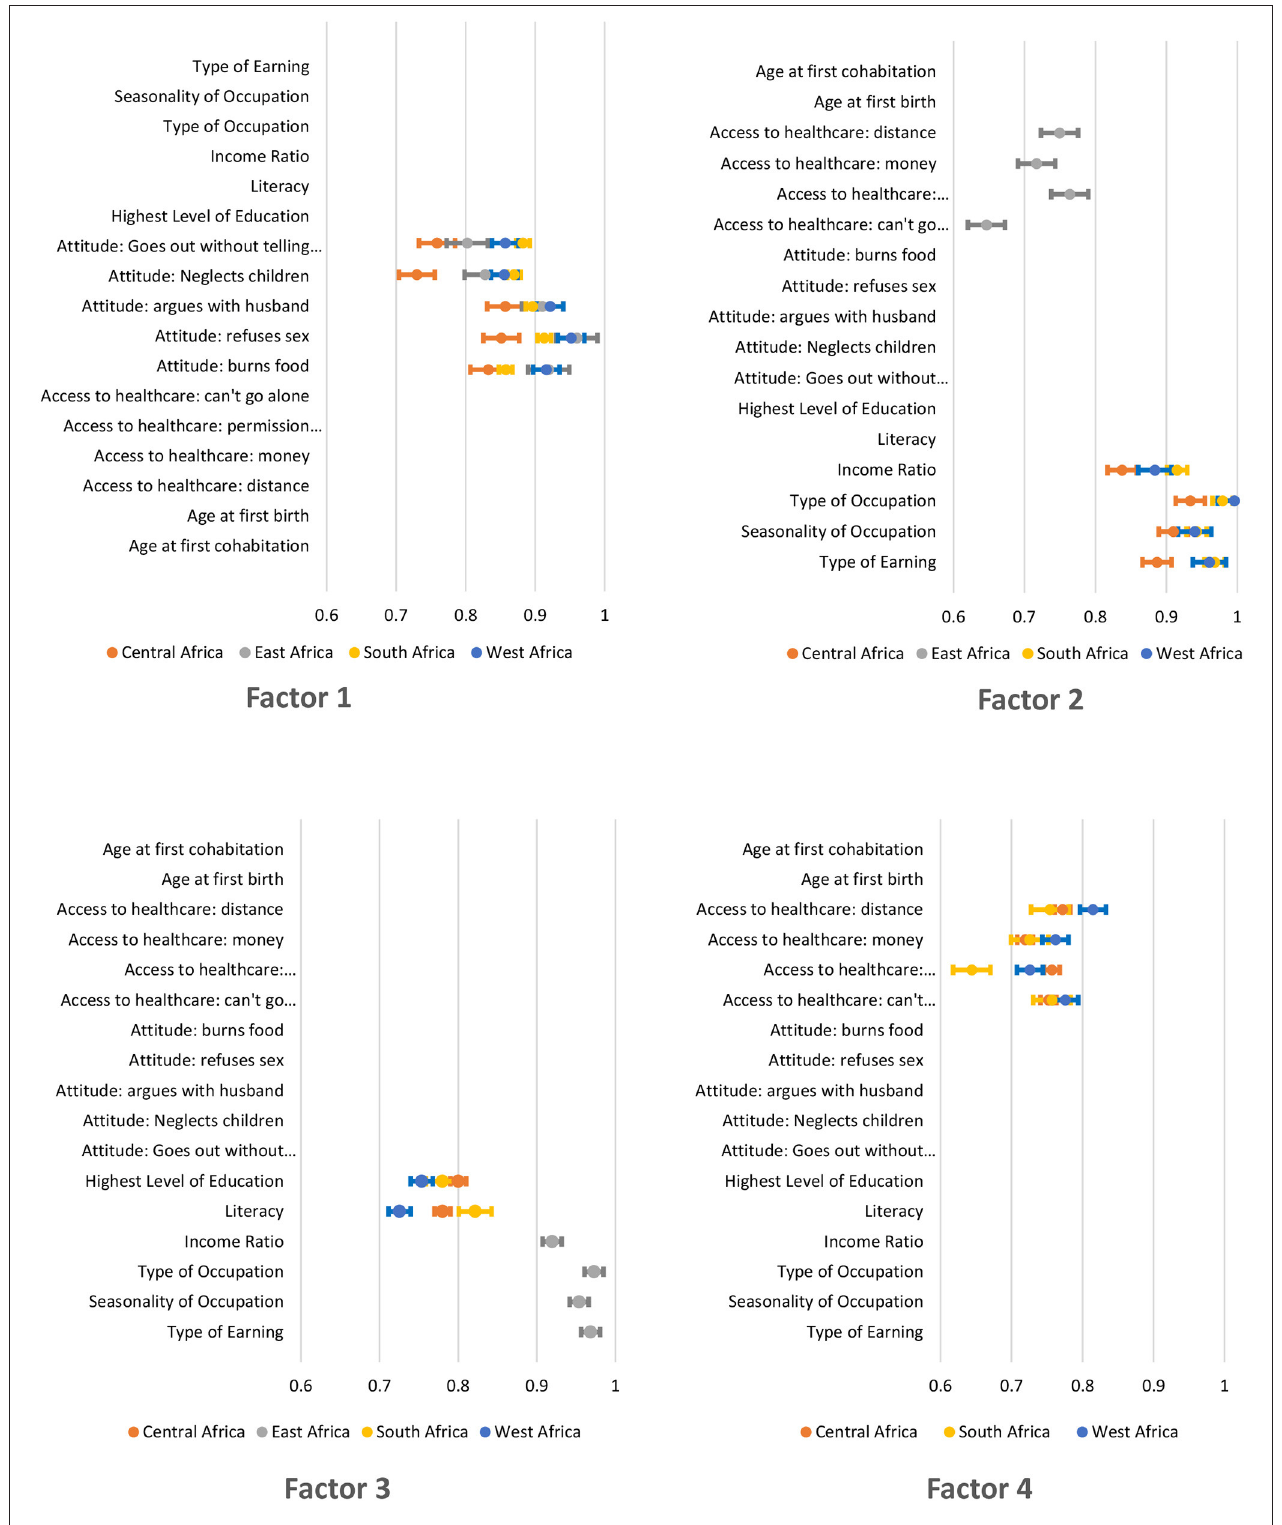
FIGURE 2 | Factor loadings for independent EFA